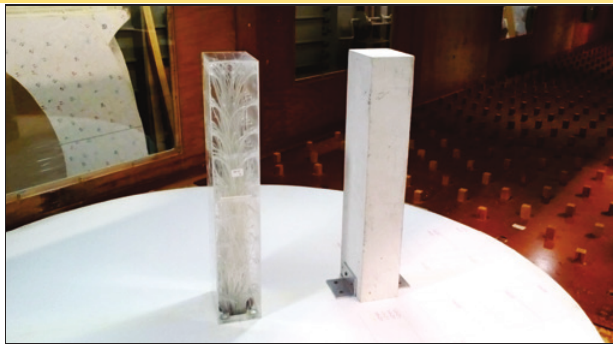
Instrumented model and CAARC standard